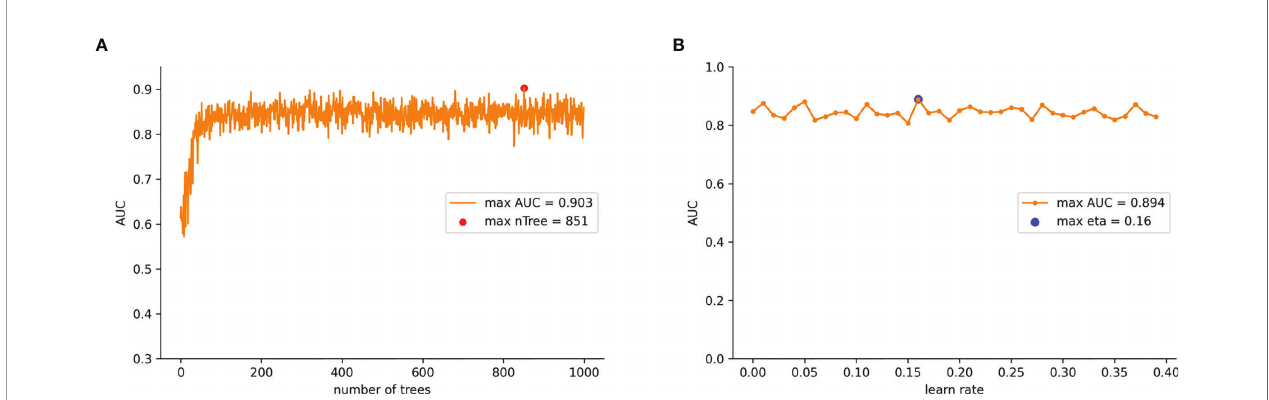
FIGURE 3 | (A) AUC values for nTree values from 1 iterates to 1,000 in the improved XGB model. (B) AUC values for learn rate from 0.01 iterates to 0.4 in the improved XGB model.